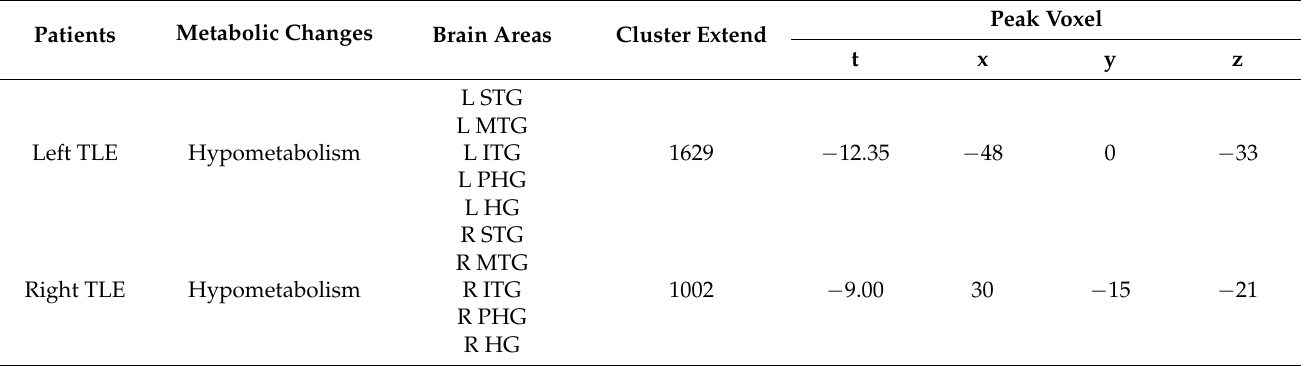
Figure 2. Localization and the GMV of hypometabolic brain regions in TLE patients compared with controls. Significantly decreased brain metabolism was found in brain areas of the ipsilateral hippocampus, parahippocampal gyrus, and superior, middle, and inferior temporal gyri using the voxel-wise comparison between groups (( A ), FDR corrected, p < 0.001). Significantly decreased GMV was found only in the ipsilateral hippocampus (( B ), p < 0.05). Table 2. Statistical maps and spatial coordinates (MNI space) of brain areas with metabolic alterations in patients compared with controls.